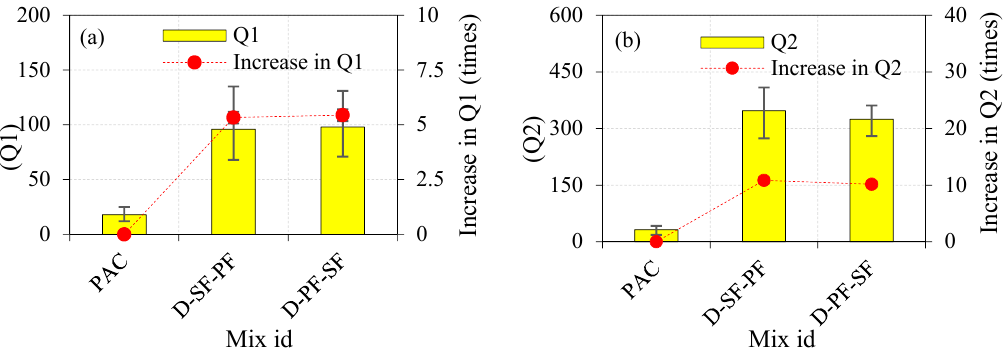
Figure 9. The effects of the double-layered FTSFC on impact strength ( a ) Q1 ( b ) Q2.